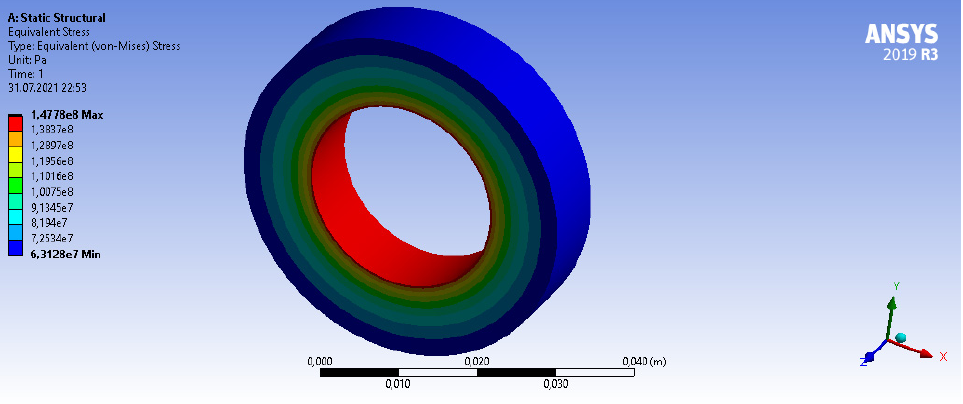
Figure 8. The result of the mechanical calculation of the internal cage of the electromagnetic suspension.